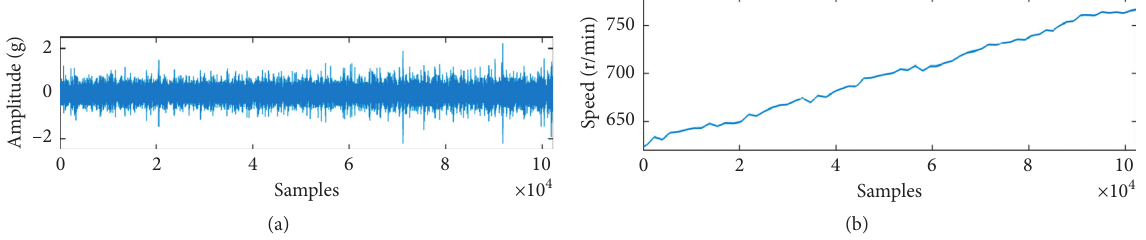
Figure 17: Fault in the outer race: (a) waveform of vibration; (b) speed trend.